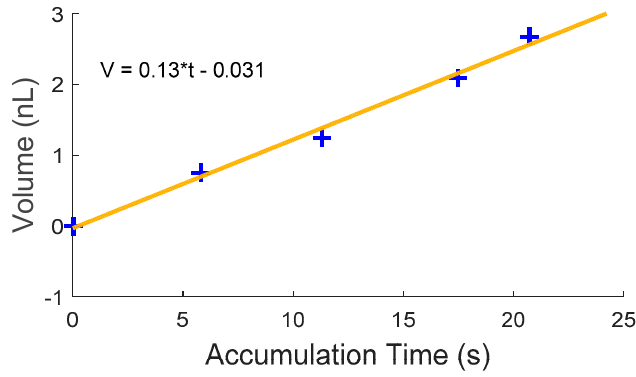
Figure 5. Linear water accumulation process.